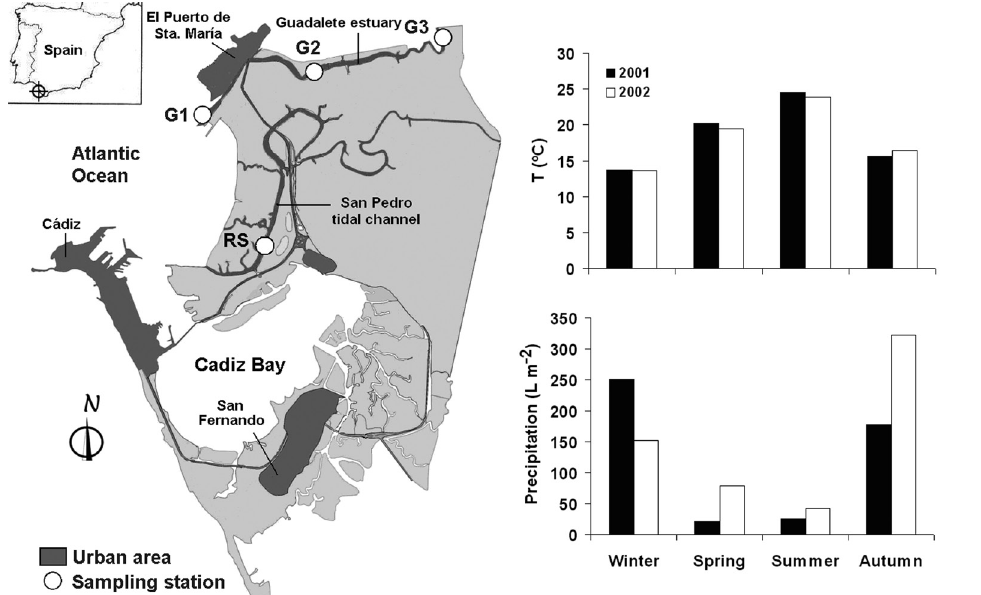
Fig . 2. – Map of the Bay of Cadiz (SW of Spain) showing its location and the positions of the sampling stations in the Guadalete estuary (G1, G2 and G3) and San Pedro tidal channel (RS). Average temperatures and seasonal precipitations during the years 2001 and 2002 in this area are also